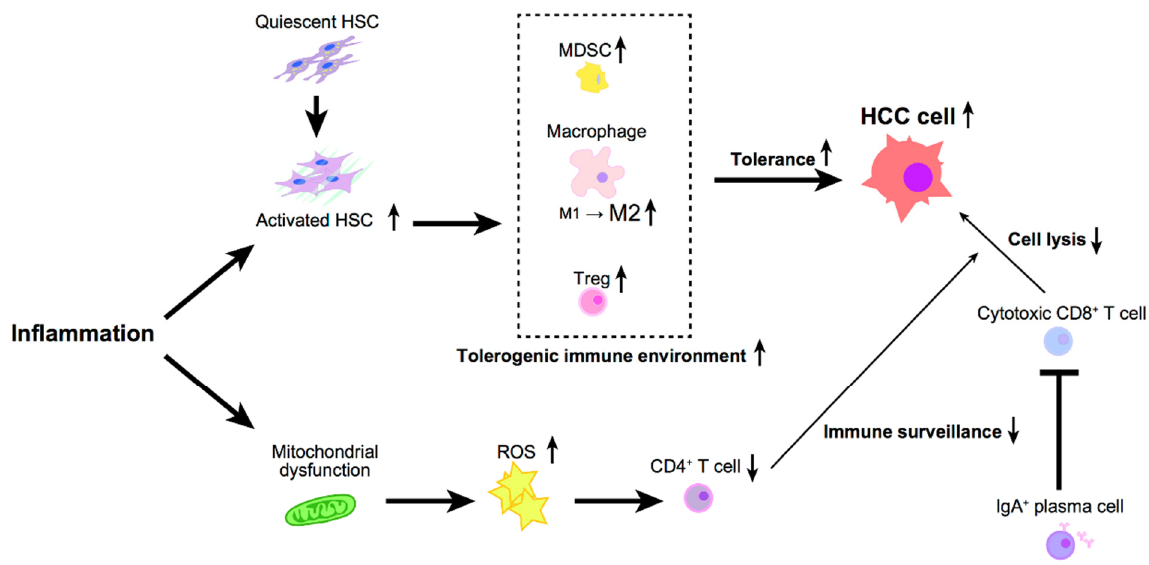
Figure 1. Inflammation oriented cancer-associated immune environment in hepatocellular carcinoma (HCC).